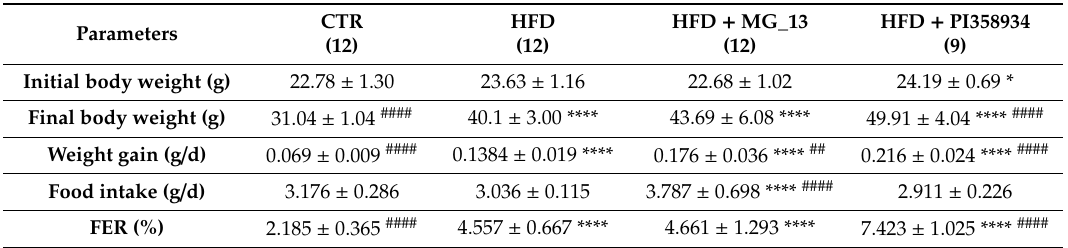
Table 1. Body weight, food intake, and food e ffi ciency ratio of CTR and high-fat diet (HFD)